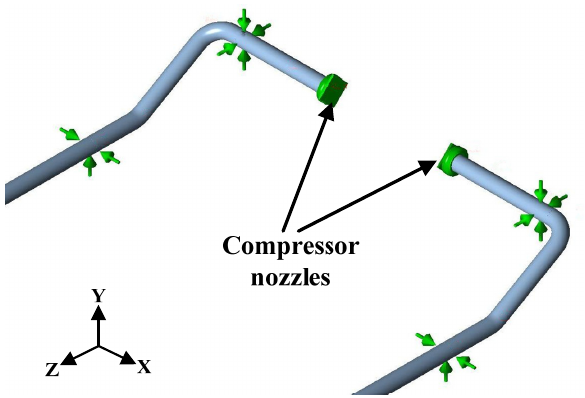
Figure 6. The model of compressor nozzle.